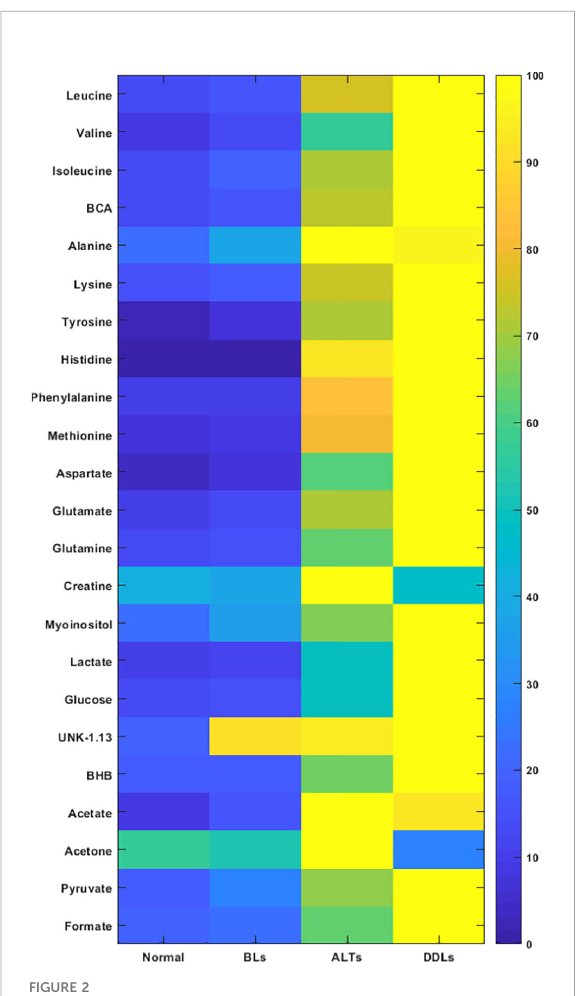
FIGURE 2 Metabolic heat map displaying differences in the metabolic pro fi le of normal fat (n = 9), benign lipoma (BLs, n = 10), atypical lipomatous tumor (ALTs, n = 7), and dedifferentiated liposarcoma (DDLs, n = 8). Statistical analysis for the different groups can be found in Table